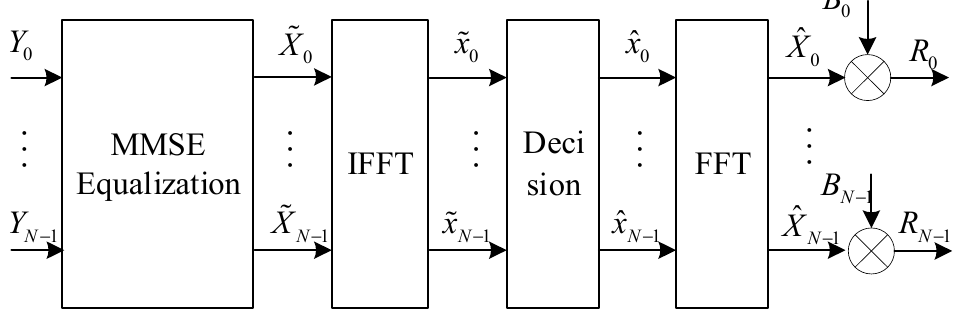
Figure 4. Feedback branch of MMSE-IBDFE.